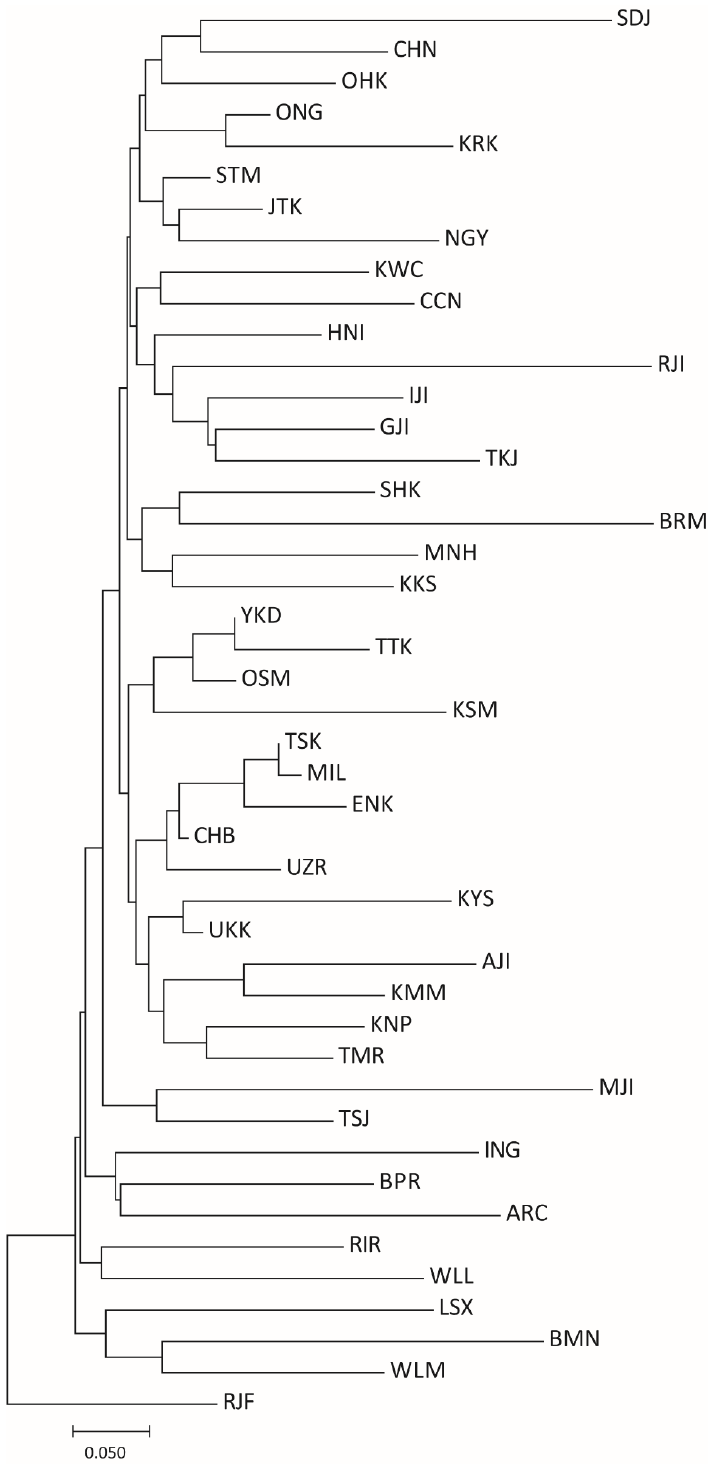
Figure 3. Phylogenetic relationships among 45 chicken breeds based on pairwise F ST genetic distance calculated with 27 microsatellite DNA markers.